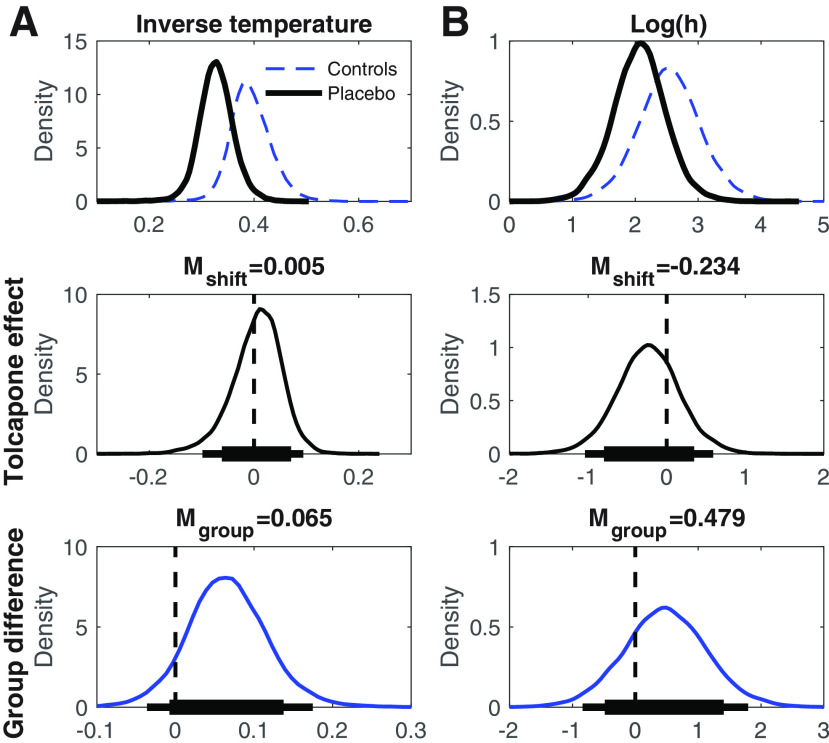
Top row, Group-level posterior distributions for parameter means under placebo (solid black line, A: softmax inverse temperature, B: log(h) [risk-taking]). The dashed blue lines plot the group posterior distributions from the control group of a previous study (n = 19; Peters and D'Esposito, 2020). Center row, Group level posterior distributions for tolcapone-induced changes for each parameter. Bottom row, Posterior distributions of group differences between gamblers under placebo from the present study and the control group from Peters and D'Esposito (2020). The thin (thick) horizontal lines in the center and bottom row indicate 95% (85%) highest density intervals.